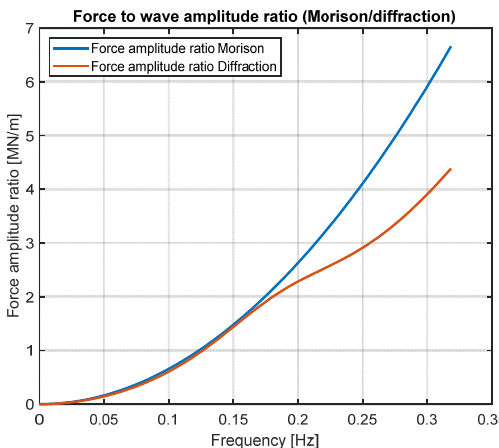
Figure 7. Wave force spectrum Morison/ Diffraction.